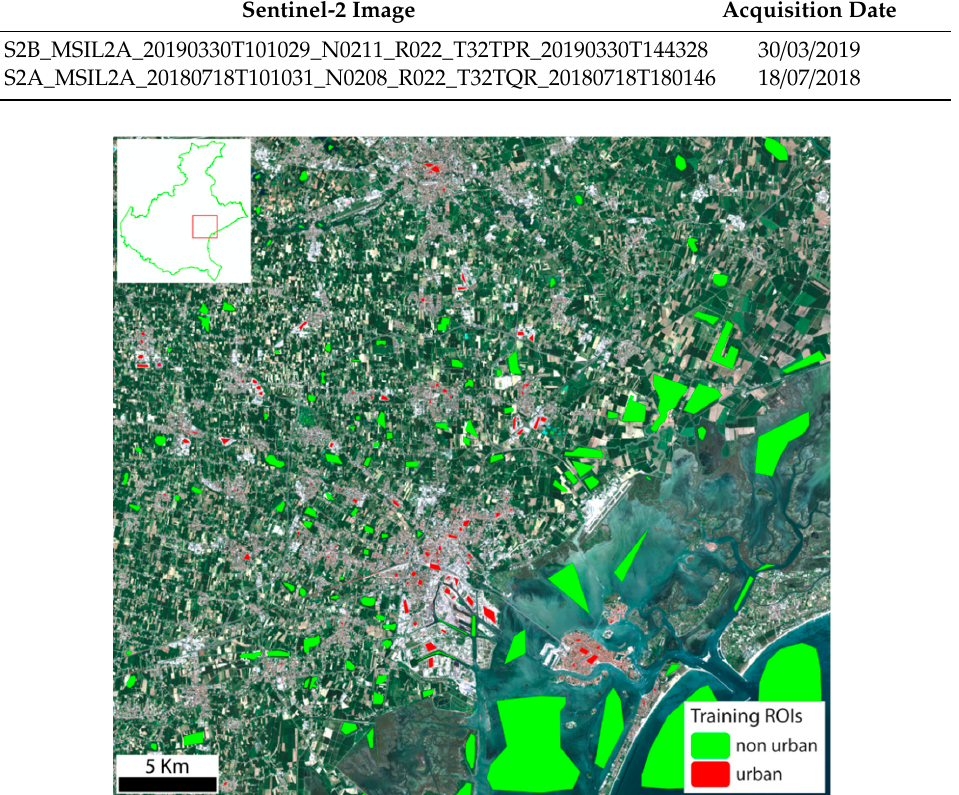
Figure 3. ROIs (regions of interest) digitized over a Sentinel-2A (MSI Level 2A) image acquired in July 2018.